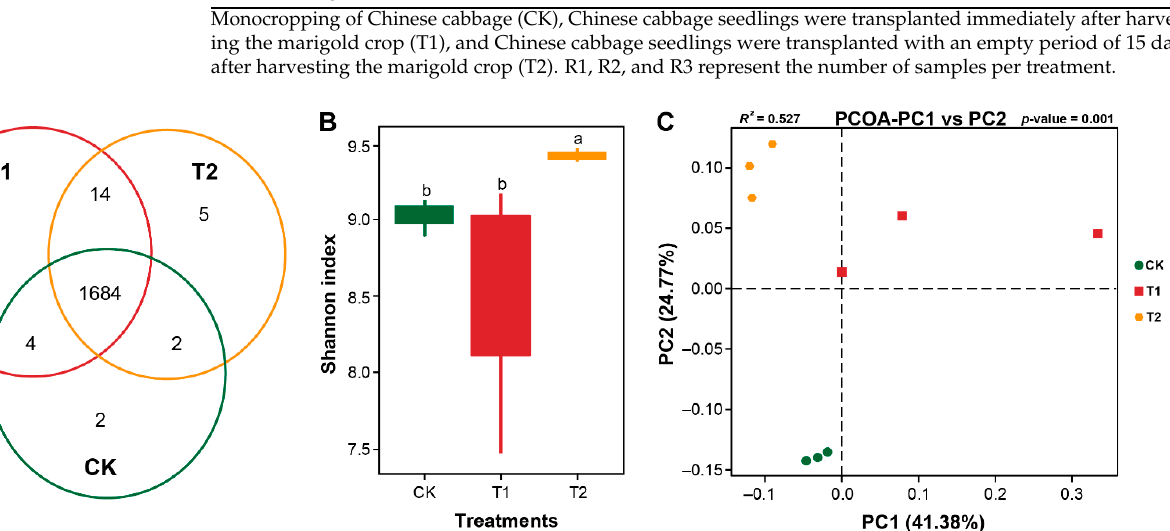
Figure 4. Diversity and structure of rhizosphere bacterial communities under marigold-Chinese cabbage crop rotation. Venn diagram showing the number of unique, shared, and common bacterial operational taxonomic units ( A ); Shannon diversity index for bacterial communities ( B ); and Principal coordinate analysis (PCoA) plots based on the Bray–Curtis dissimilarity matrix, showing the changes in the structure of bacterial communities ( C ). Different lowercase letters on each box represent the significant difference among treatments, according to a least significant difference test (LSD; p < 0.05). Monocropping of Chinese cabbage (CK), Chinese cabbage seedlings were transplanted immediately after harvesting the marigold crop (T1), and Chinese cabbage seedlings were transplanted with an empty period of 15 days after harvesting the marigold crop (T2). Table 2. High throughput sequencing data through amplification of the V3-V4 variable region of 16S rRNA.